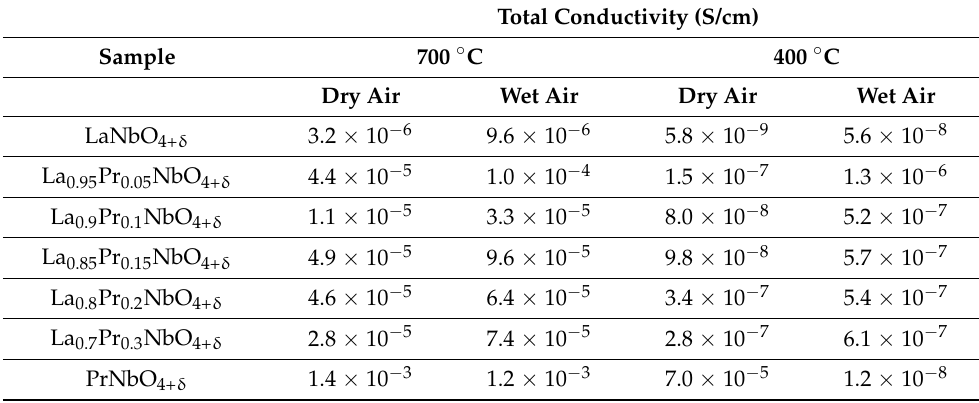
Table 4. The total conductivity of La 1 − x Pr x NbO 4+ δ in dry (pO 2 = 2.0 × 10 − 1 atm, pH 2 O = 6.0 × 10 −